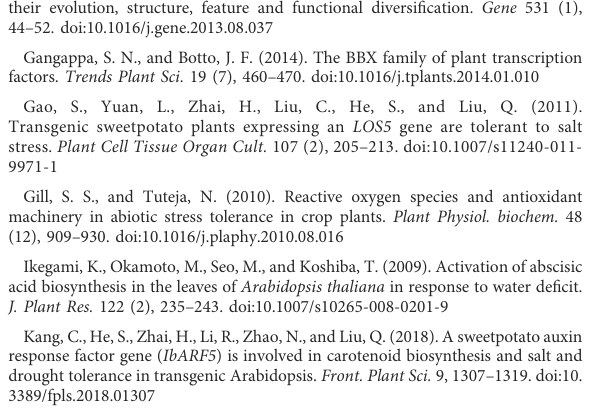
SUPPLEMENTARY FIGURE S1 Phylogenetic analysis of IbBBX28 in different